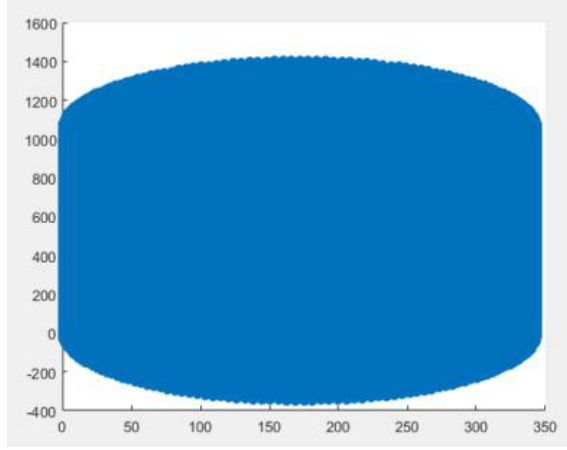
Figure4. Ground Scanning Area Simulation